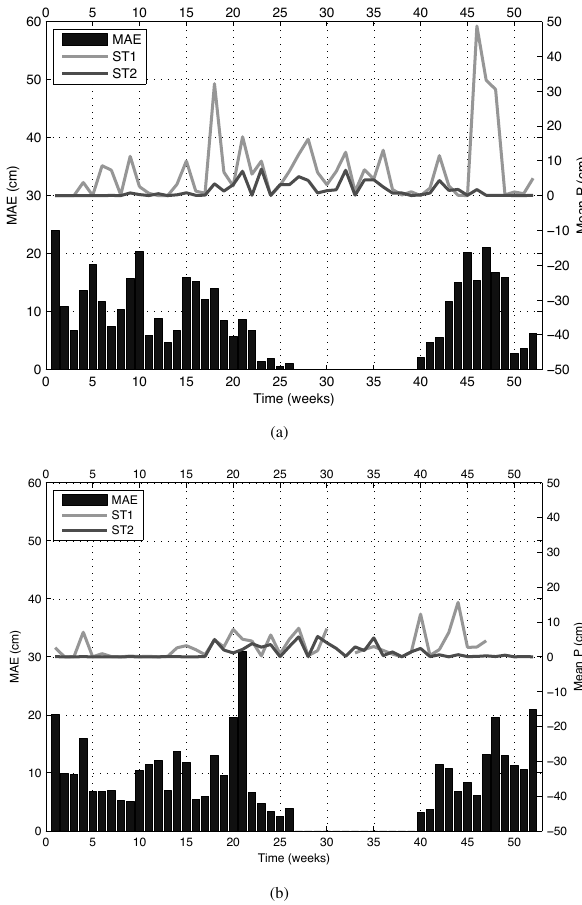
Fig. 5. Mean Absolute Error (MAE) in a regression task as a func- Fig. 5. Mean absolute error (MAE) in a regression task as a function tionofweeksduringtheyears2002(a)and2003(b)comparedwith of weeks during the years 2002 (a) and 2003 (b) compared with the the mean weekly liquid precipitation measured close at the altitudi- mean weekly liquid precipitation measured close at the altitudinal nal limits of the data set: ST1 485 m a.s.l. and ST2 2150 m a.s.l. limits of the data set: ST1 485ma.s.l. and ST2